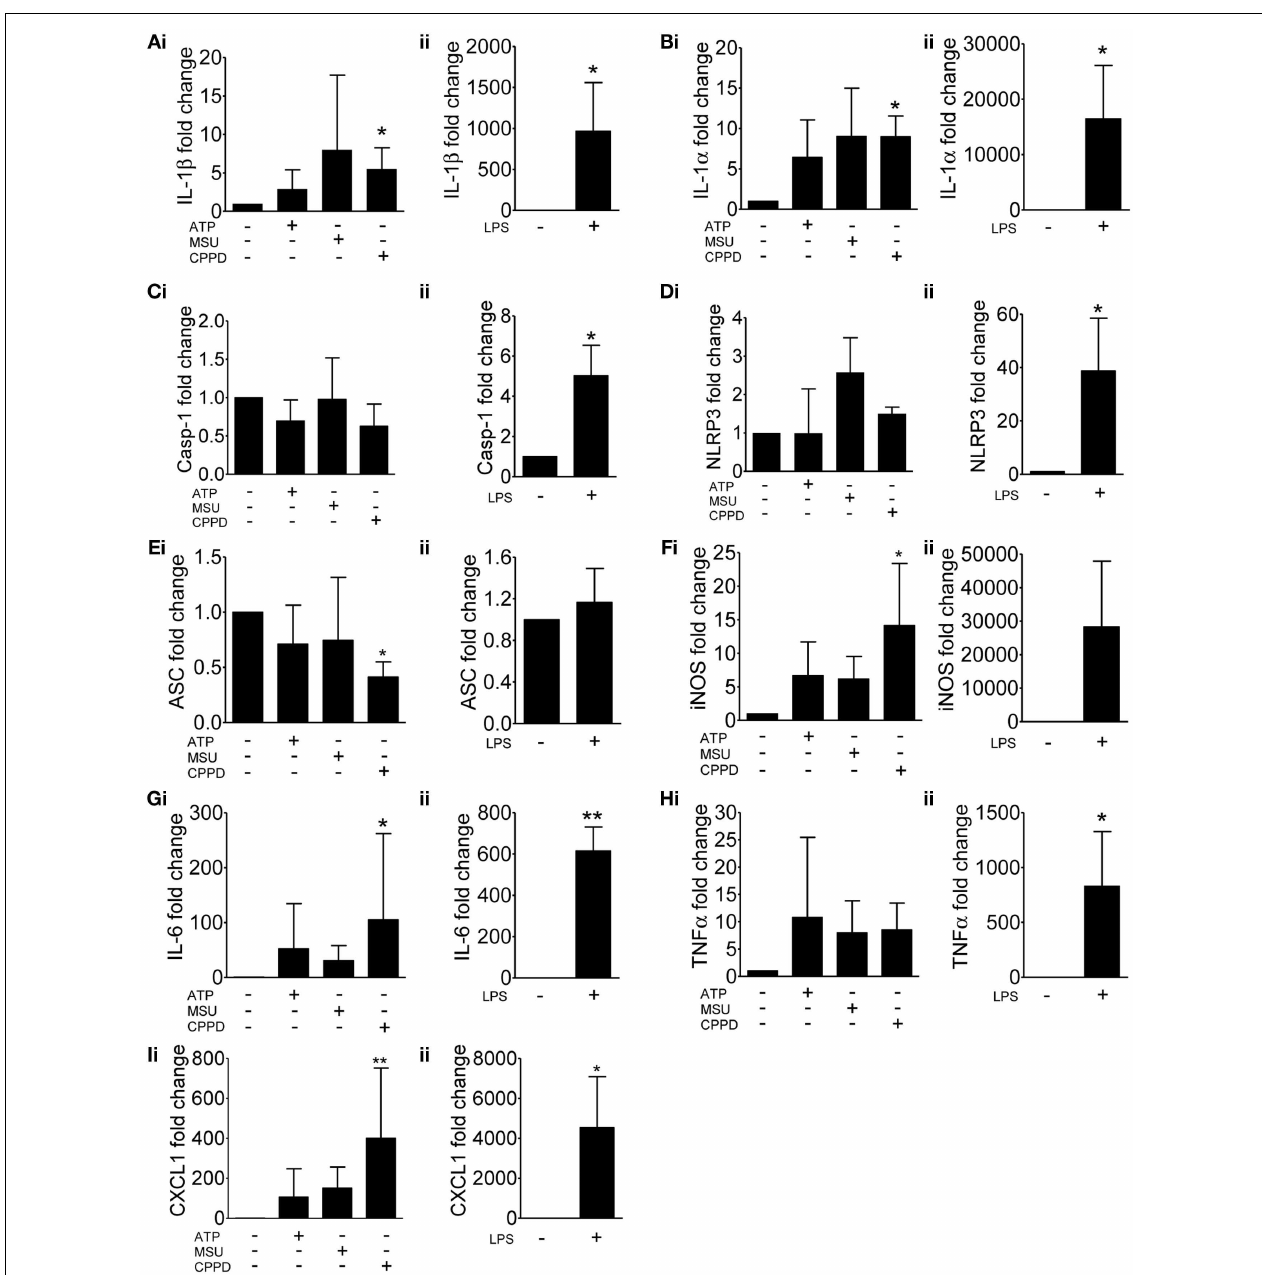
SDHA across each treatment and fold change was expressed relative to basal RNA levels from untreated mixed glia.The genes analyzed were IL-1 β (A) , IL-1 α (B) , caspase-1 (C) , NLRP3 (D) , ASC (E) , iNOS (F) , IL-6 (G) ,TNF α (H) , and CXCL1 (I) . Data are pooled samples from at least five separate experiments. ** P < 0.01, * P < 0.05, vs.